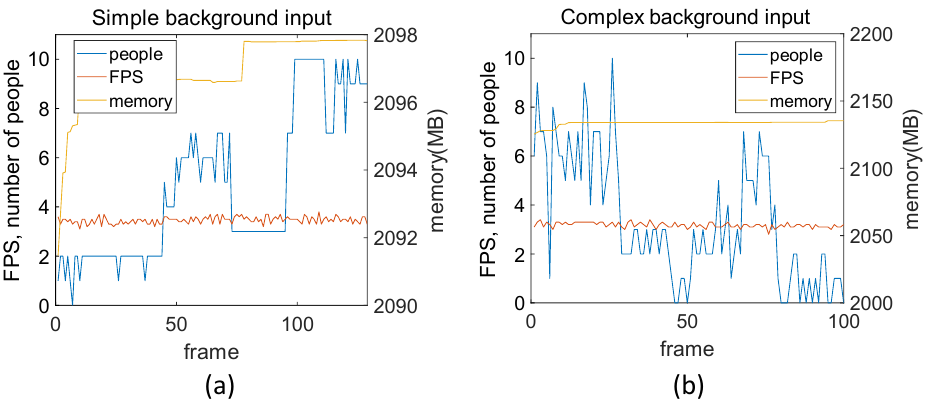
Figure 17. Time measurement result of complexity of background: ( a ) simple background and ( b ) complex background.